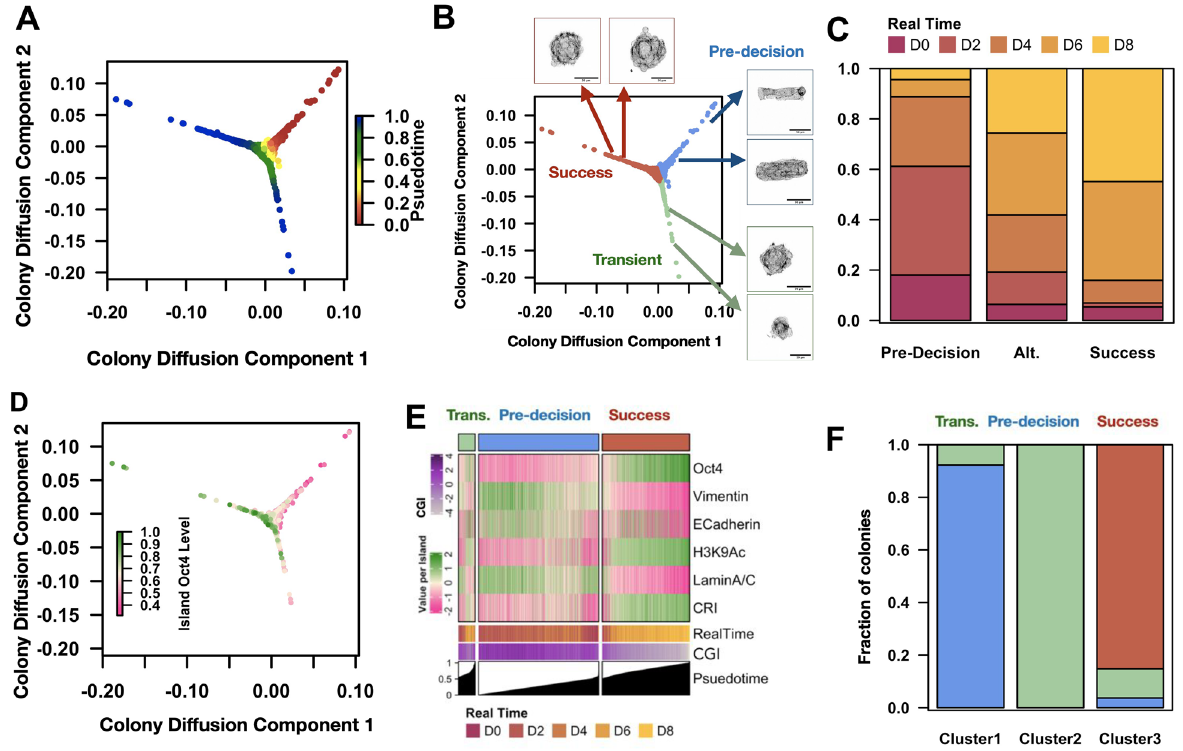
Figure 3. Diffusion analysis reveals stages of laterally confined growth: ( A ) Diffusion Map of colonies from Day 0 to 8 color coded with the inferred pseudotime. The sequential color indicates the position of each cell in pseudotime starting from 0 to 1. ~ 3000 colonies were used in total from 6 biological replicates. ( B ) The branches are defined as Pre-decision (blue), Transient (Trans.) (green) and Success (maroon) separately. Representative micrographs of images of the various branches are displayed along the margins. The arrows indicate their approximate location. Scale bar = 20 µm. ( C ) The branch membership fraction of colonies from Day 0 to Day 8. The color code is displayed along the top margin. ( D ) Diffusion Map of colonies color coded with the average Oct4 levels per colony. n = 3 biological replicates. The values are normalized within each biological replicate. ( E ) Heatmap depicting the branch-wise protein expression and Chromatin Reorganization Index (CRI) of colonies ordered with increasing pseudotime. Note that each column is a colony. The first column- side color bar represents the real time of the colonies between Day 0 and 8. The second column-color bar represents the Colony Growth Index (CGI) values of the colonies. The histogram at the bottom panel depicts the corresponding pseudotime value of the colonies (see “Methods and materials” section). ( F ) The branch membership fraction colonies of the three D10 clusters identified Fig. 1E. n = 68 colonies from 3 biological